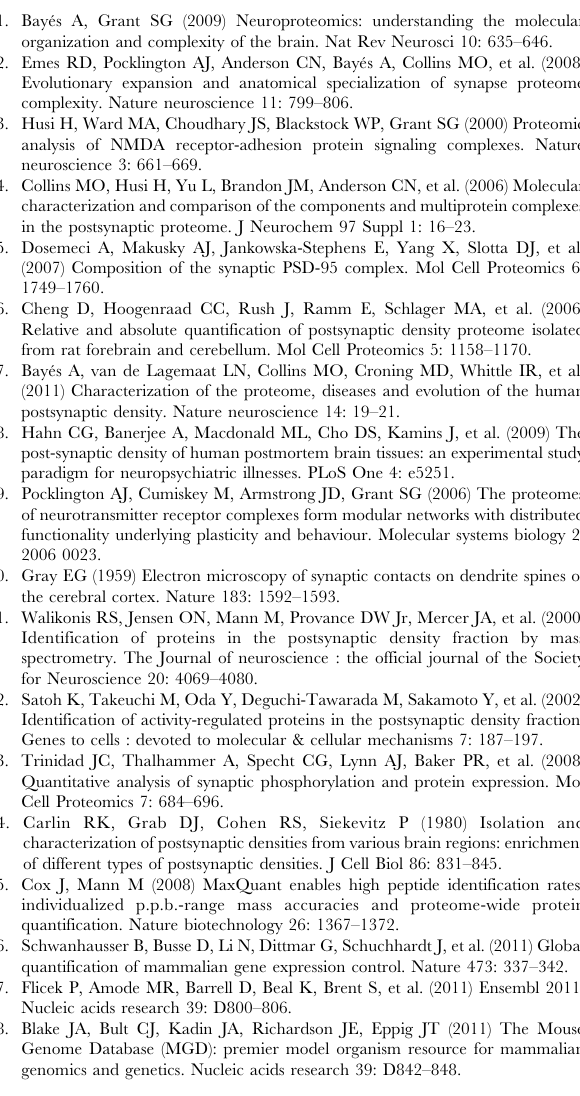
would have been identified by chance. Over or under-represen- tations are shown by a ( + ) or ( 2 ) symbol respectively. Table S10 Analysis of dN/dS values from mouse and human PSD proteins. dN, dS, dN/dS and median dN/dS values are given for proteins found in human and mouse cortical PSD, and proteins exclusive or significantly enriched to each species’ PSD. All values were obtained from Ensembl